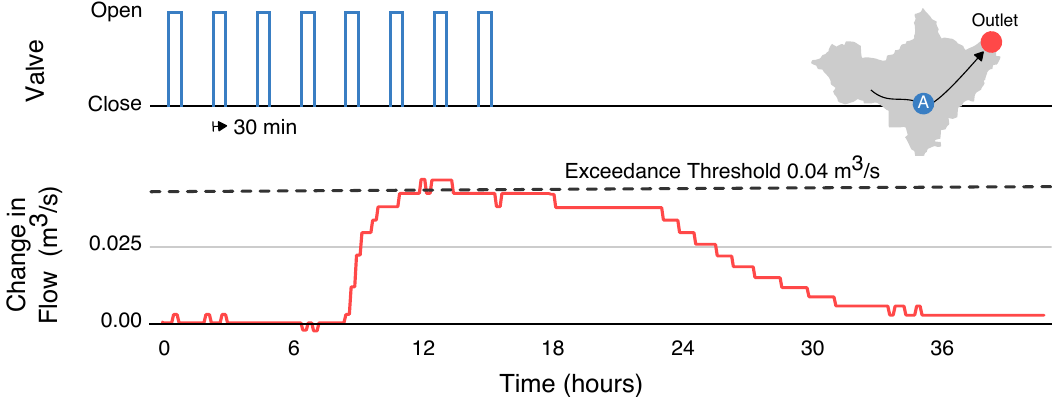
Figure 5. Generating a set-point hydrograph. Small, evenly spaced pulses (30-min duration) are released from the controlled basin. The pulses disperse as they travel through the 6 km-long stream, leading to a relatively flat response at the outlet of the